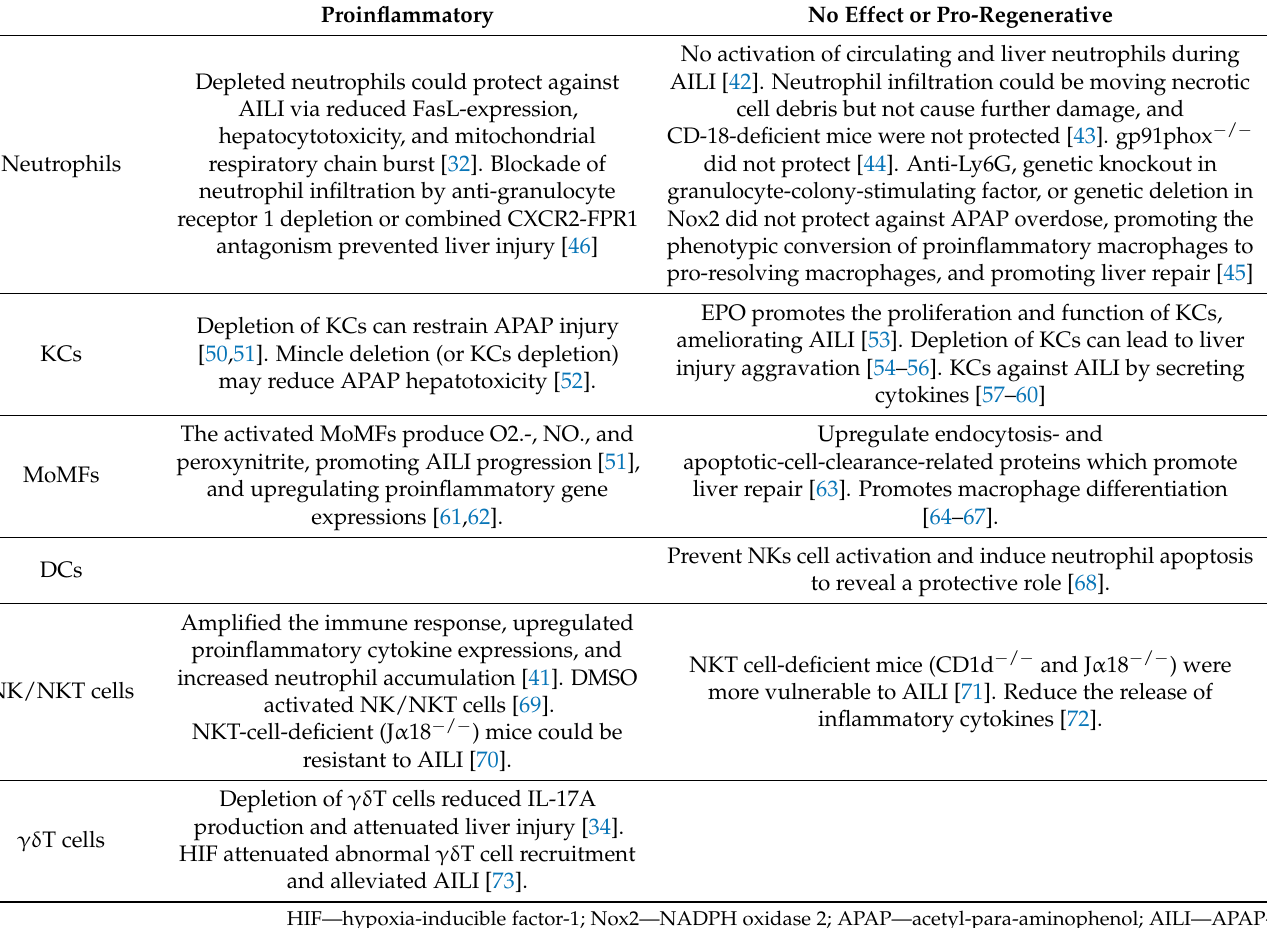
Table 1. The dual role of immune cells in AILI.